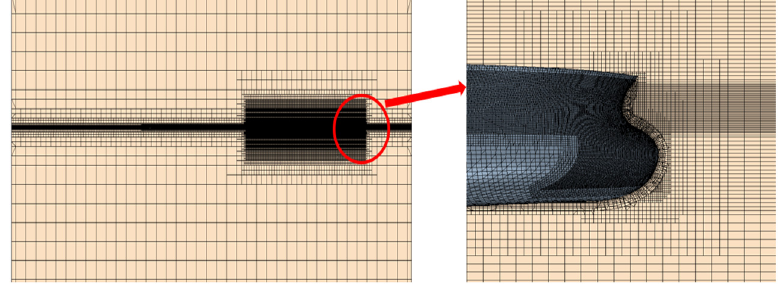
Figure 10. Grid diagram of the longitudinal section of the computing domain.